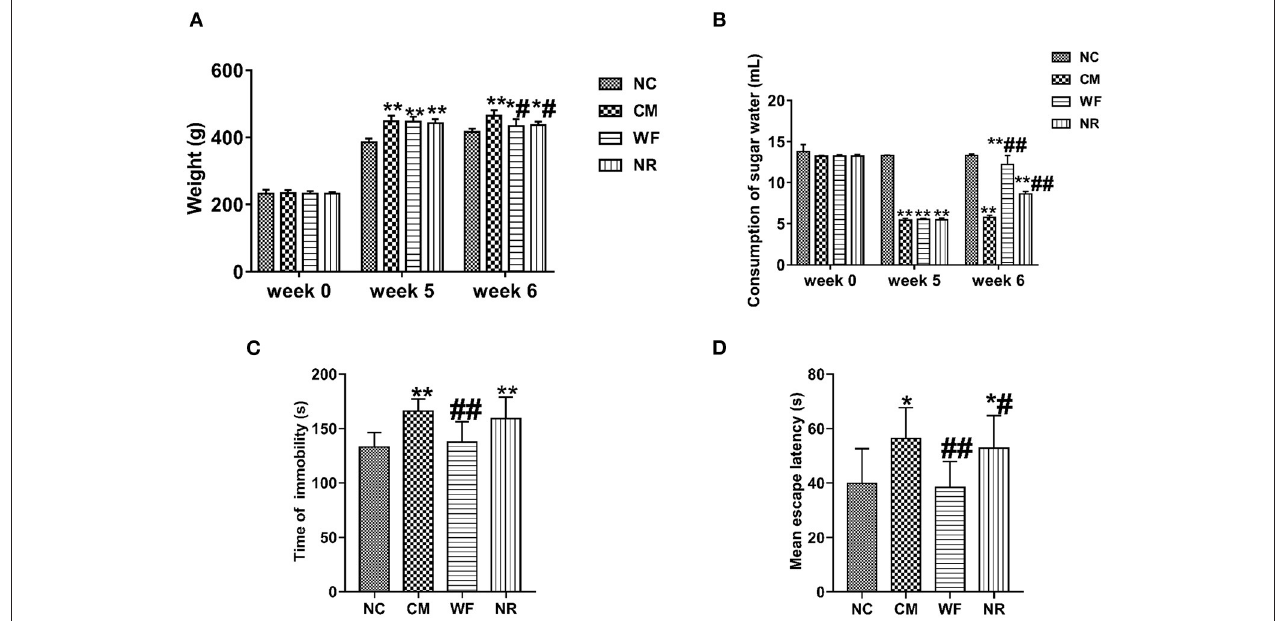
FIGURE 3 | The waterfall forest environment (WF) improves hopelessness of chronic stress rats. (A) Effects of WF on body weight of rats in all the groups. (B) Effects of WF on the consumption of sugar water in all the groups. (C) Effects of WF on immobility time of rats in the tail suspension test. (D) Effects of WF on escape latency of rats in the Morris water maze test. * p < 0.05 and ** p < 0.01 vs. the normal control (NC) group. # p < 0.05 and ## p < 0.01 vs. the chronic stress model (CM)